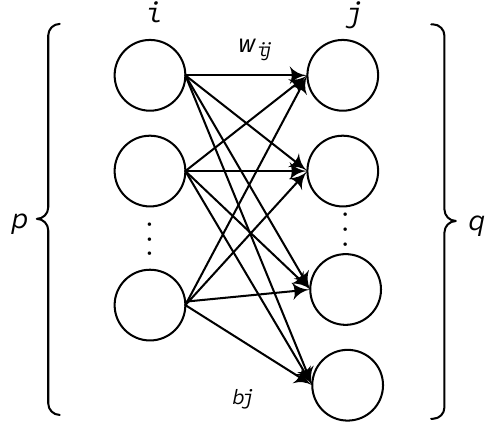
Figure 3. Fully connected layer. p represents the number of inputs; q represents the number of outputs; w ij is the weight; b j is the bias